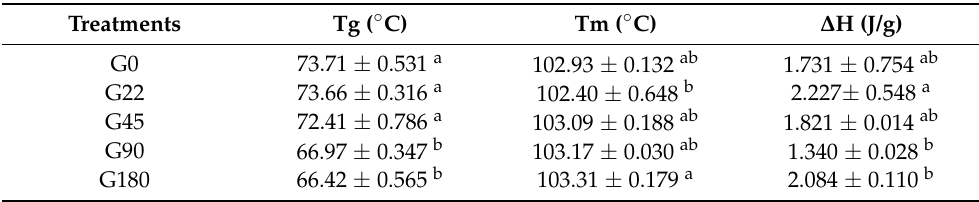
Figure 6. TEM images of the green synthesized AgNPs at different times. The A.P.S. means Average Particle Size. Table 2. Thermal properties of gelatin films with different concentrations of silver nanoparticles. Different letters represent significant differences ( p <